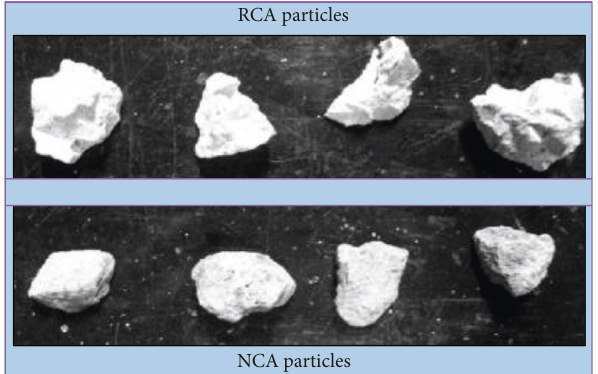
Figure 1: Representative sample of the RCA and the NCA particles exhibiting their